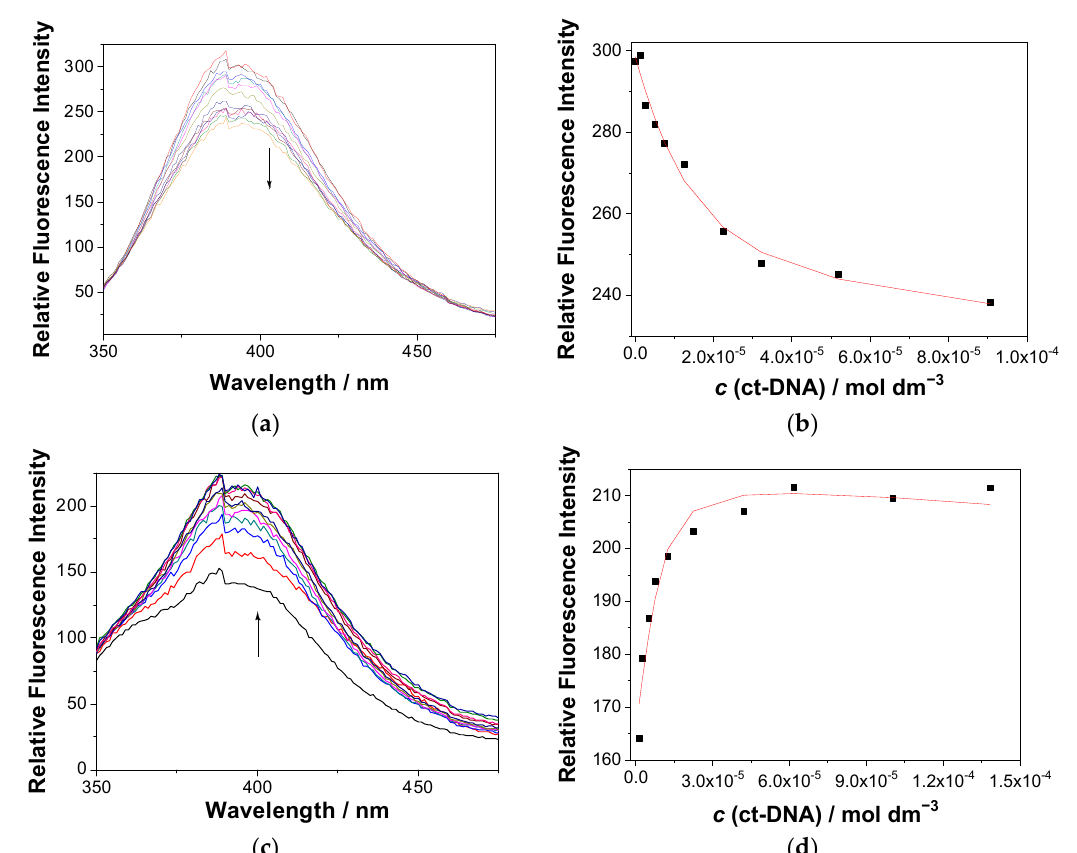
Figure 3. ( a , c ) Fluorescence spectra ( λ exc = 320 nm) of 1a (top) and 1e (bottom) ( c = 2.0 × 10 − 6 M) at different concentrations of ct-DNA. ( b , d ) Dependence of the fluorescence intensity at 390 nm for the solution of 1a ( a , b ) and 1e ( c , d ); the black dots are experimental values, whereas the red line is a fitted value according to the Scatchard model [88]. The measurements were performed in Na cacodylate buffer (pH 7.0, 50 mM at 25 °C, containing <1% DMSO).